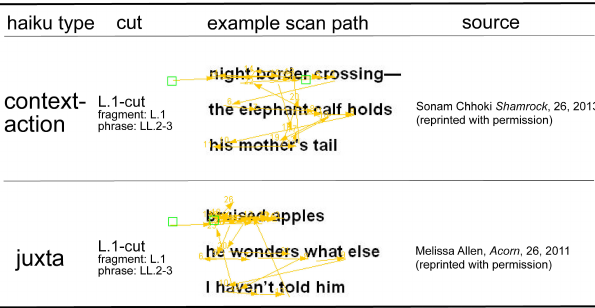
Figure 3. Scan paths produced by one participant for two of the haiku